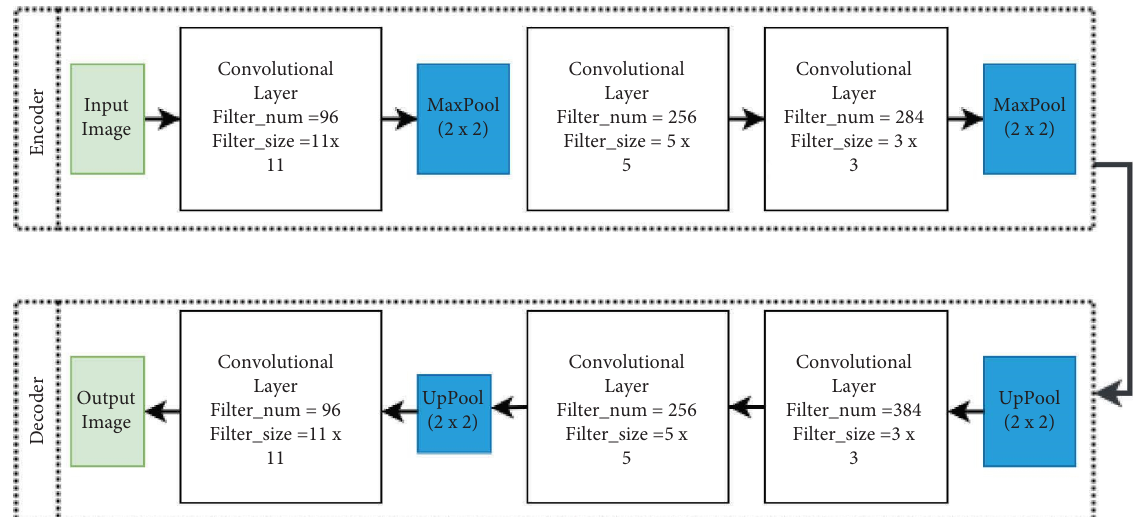
Figure 8: Te architecture of the proposed convolutional auto-encoder. Filter number stands for the number of the flters of that associated layer. Filter size refers to the size of the convolutional flter.